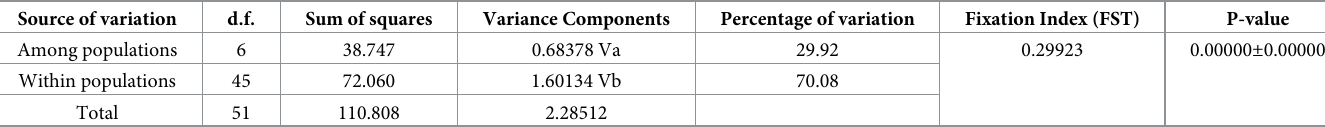
Table 6. AMOVA analysis of T cattle of Andaman and different regions of Indian subcontinent and Island Southeast Asian